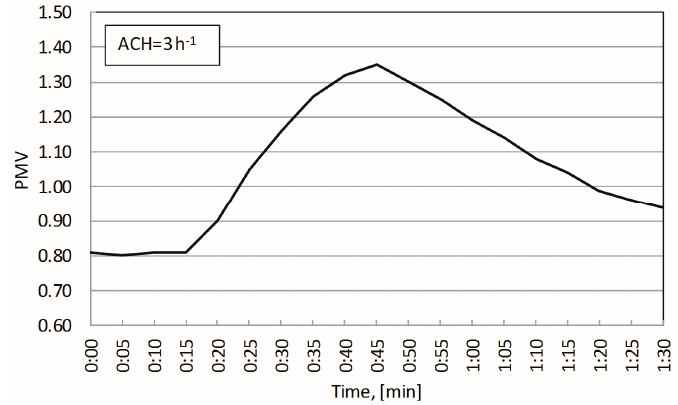
Figure 14. PMV variation in the test room with radiation and personalized ventilation.